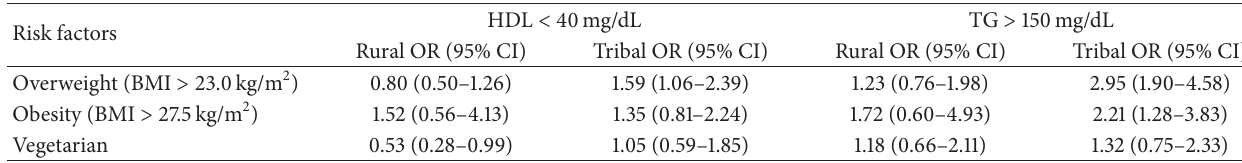
Table 4: Risk quantification for at risk level of HDL and TGs in rural and tribal area of a Himalayan state, Himachal Pradesh, India, 2010. HDL < 40 mg/dL TG > 150mg/dL Risk factors Rural OR (95% CI) Tribal OR (95% CI) Rural OR (95% CI) Tribal OR (95% CI) Overweight (BMI > 23.0 kg/m 2 ) Obesity (BMI > 27.5 kg/m 2 )